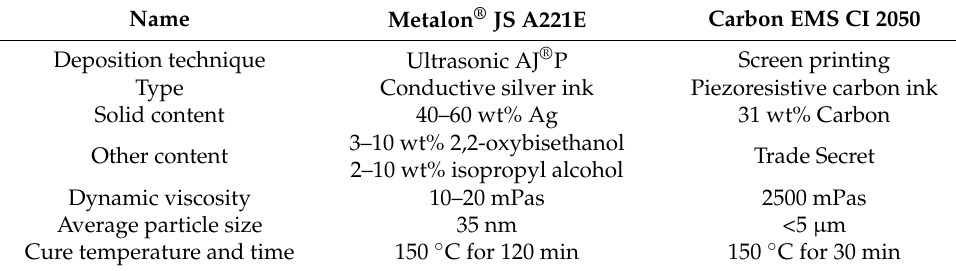
Table 2. Properties and details of the ink